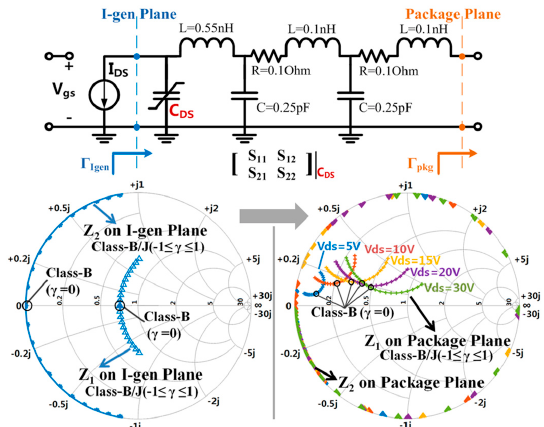
/ J power amplifier (PA)